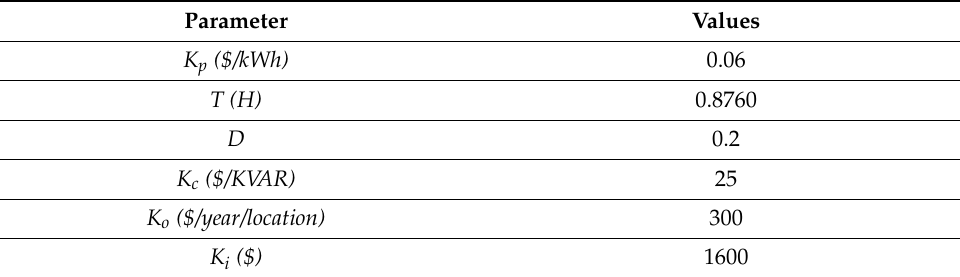
Table 2. The parameters for recalculation of the cost